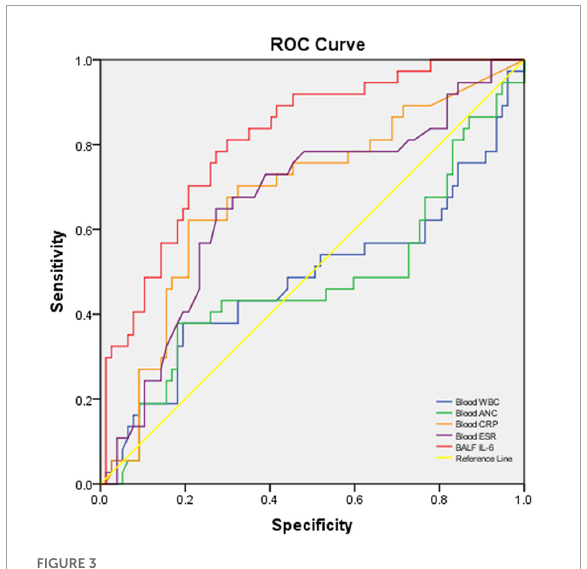
FIGURE3 ROC curve of blood WBC, ANC, CRP, ESR, and BALF IL-6 for discriminating severe and moderate CAP cases vs. mild